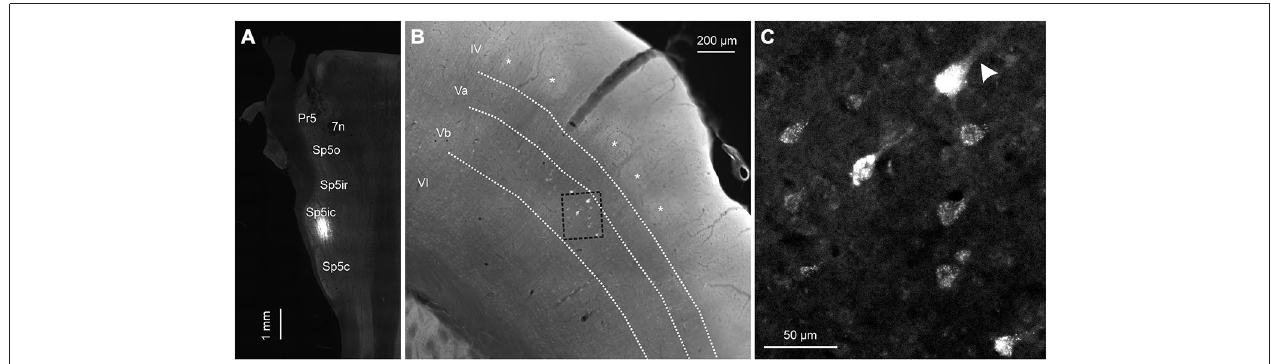
FIGURE 8 | A representative example showing the laminar distribution of retrogradely labeled cells in cortex following a tracer deposit into the Sp5ic. (A) Horizontal section through the brainstem showing the location of the injection site in Sp5ic. (B) Coronal section through cortex showing the layer IV barrels (asterisks) in relation to the retrogradely labeled cells. The layer boundaries have been drawn from neighboring sections stained for CO and superimposed on this section. (C) Inset from (B) , shown at higher magnification, showing the retrogradely labeled cells with the presence of apical dendrites